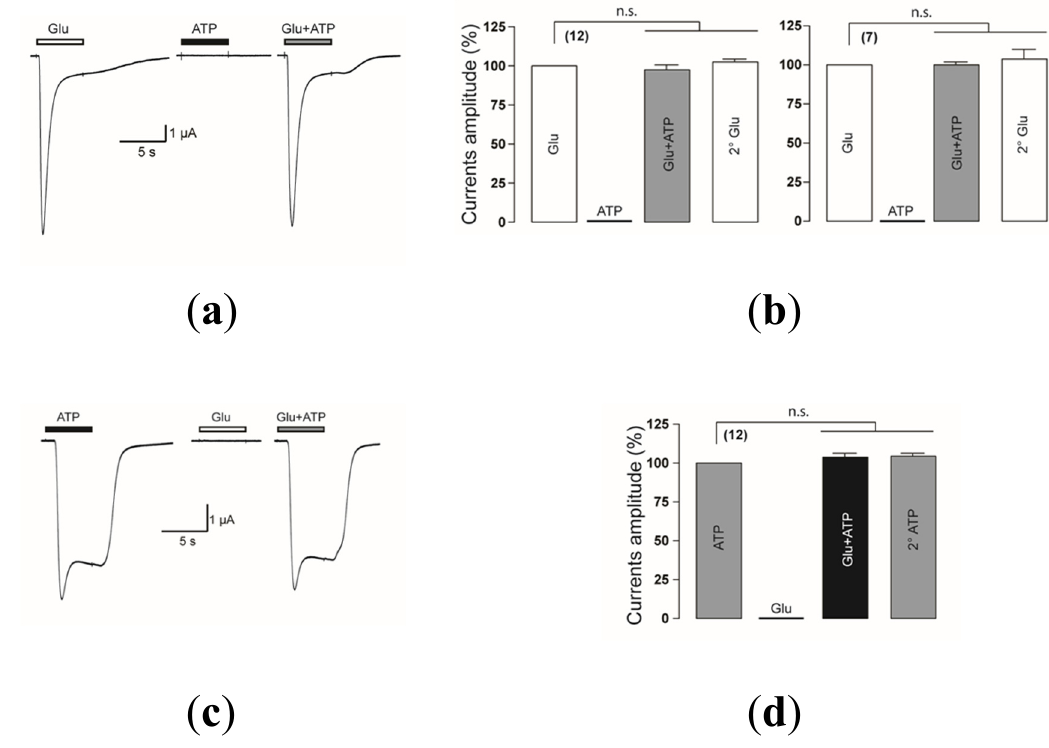
Figure A2. Application of ATP agonist does not affect Glu responses when NMDARs are expressed alone and conversely, application of Glu does not modulate ATP responses when P2X are expressed alone. ( a ) Representative current recorded from an individual oocyte GluN2B-containing NMDARs responding to 100 µ M : Glu (left), ATP (middle), or Glu + ATP (right) are shown.; ( b ) Bar graphs representing the current obtained from application of agonists, normalized to the Glu response for each GluN2B-expressing oocyte.; ( c ) Representative current recorded from an individual oocyte expressing only P2X2 responding to 100 µ M : ATP (left), Glu (middle), or Glu + ATP (right) are shown. ( d ) Bar graphs representing the current obtained from application of agonists, normalized to the ATP response for each P2X2-expressing oocyte. The data are expressed as mean ± SEM. ns > 0.05 (one-way ANOVA).